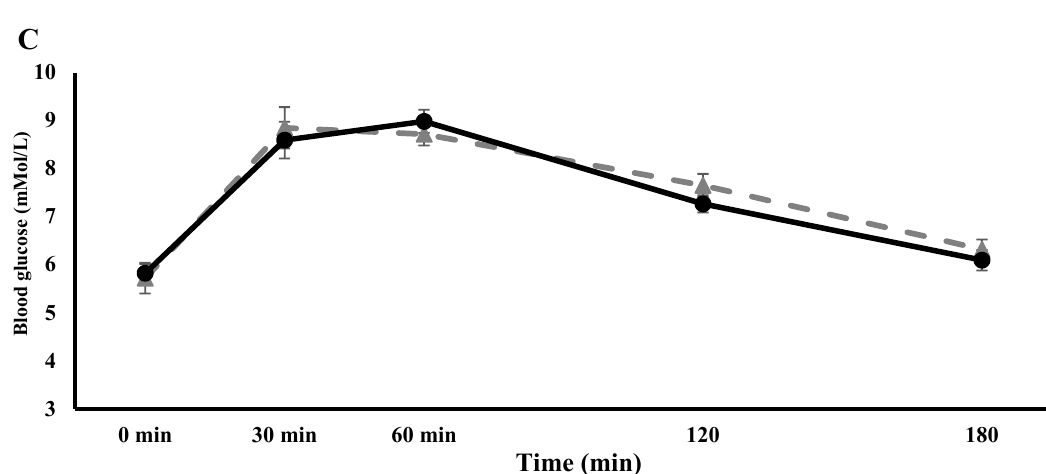
Figure 2. Insulin and glucose homeostasis indices from the chronic study. ( A ) The line graph presents mean fasting plasma glucose and the bar graph shows fed plasma glucose measured at mid-study; ( B ) Fasting and fed plasma insulin levels. HOMA-IR in fed state was calculated from fed glucose and insulin values. Asterisk indicates a significant difference between groups ( t -test, p ˂ 0.05); ( C ) Blood glucose measured by glucometer after a glucose load during an OGTT. Table 1. Results of plasma biochemistry tests performed before and after the intervention presented as mean (SEM). Significant p-values in the between-group analysis are in bold. Control Group Nutraceuticals Group p -Value of Control Group p -Value